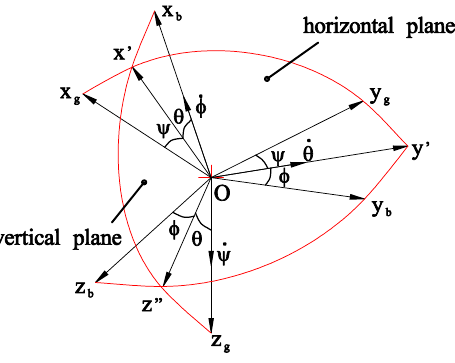
Figure 3. Duct deflection in three flight states.